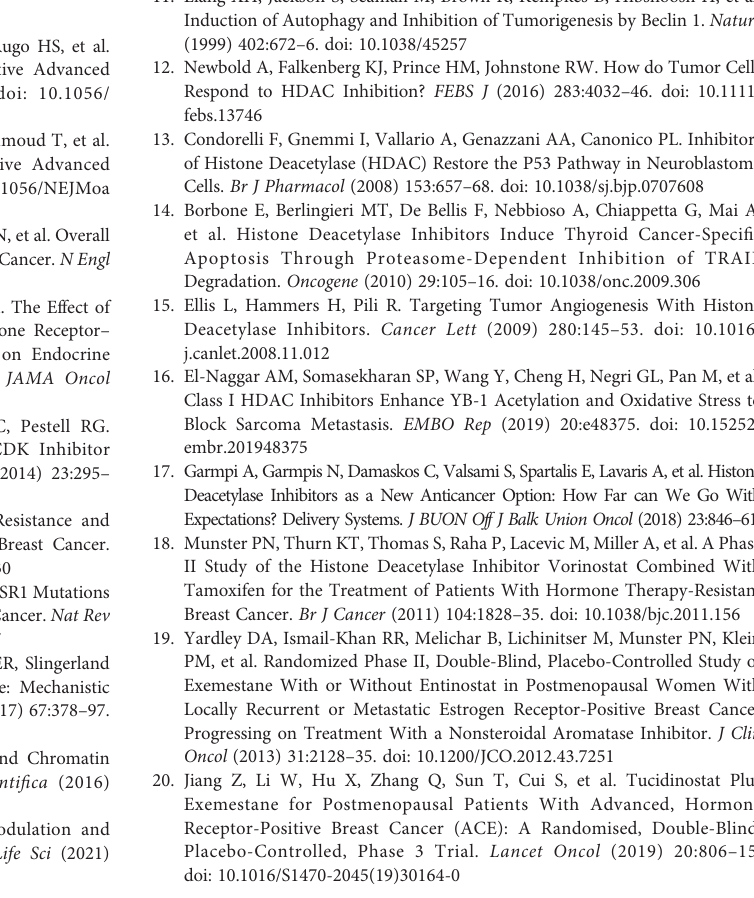
Supplementary Figure 1 | Funnel Plots for publication bias evaluation: (A) ORR; (B) CBR; (C) PFS; (D) OS; (E) AllAE; (F) Grade ≥ 3 AE; (G) Dosemodi fi cation due to AE; (H) Treatment discontinuation due to